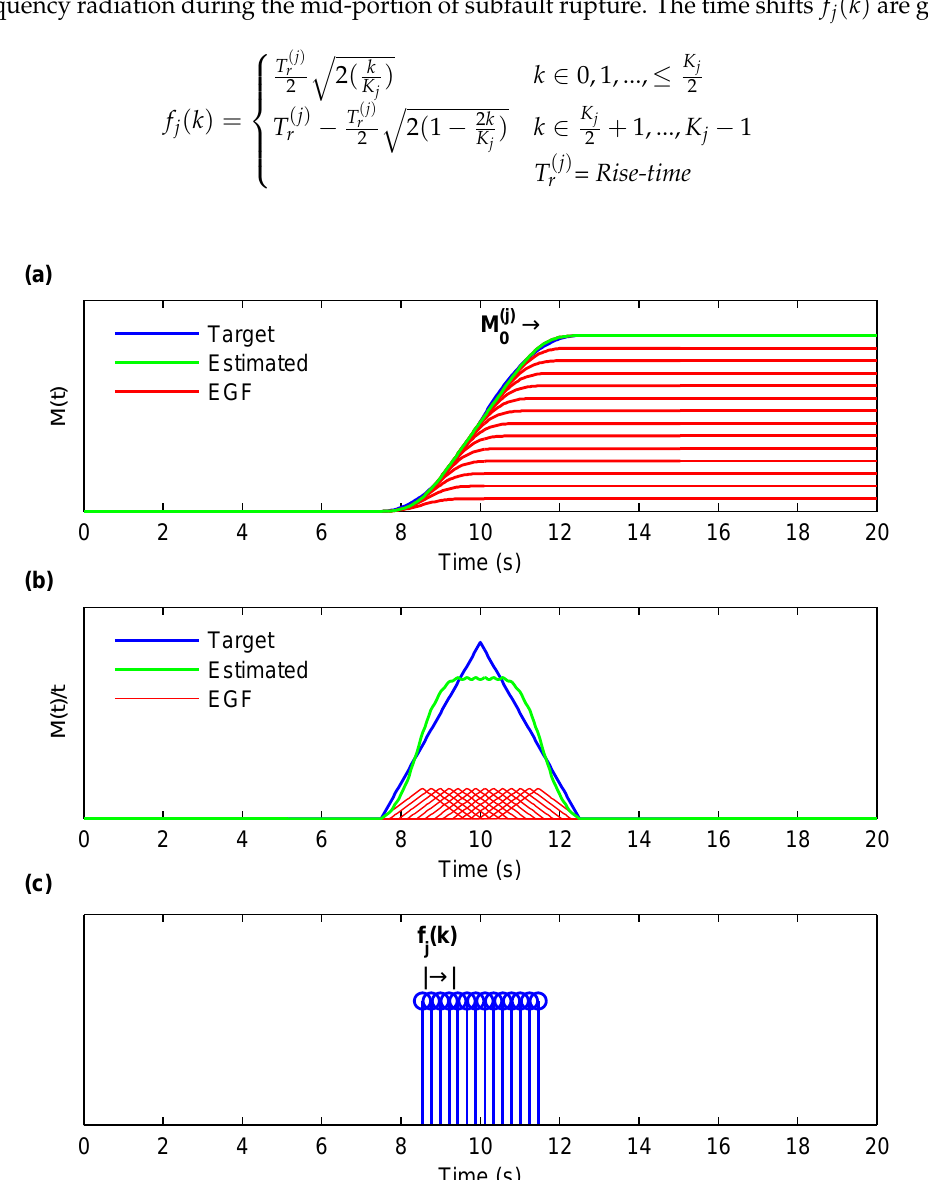
Figure 2. Time shifts used in previous studies. ( a ) moment (or slip) vs. time and approximation using multiple EGFs. ( b ) Moment-rate (or slip rate) vs. time and approximation using multiple EGFs. ( c ) Subfault j time shifts f j ( k ) used in the EGF